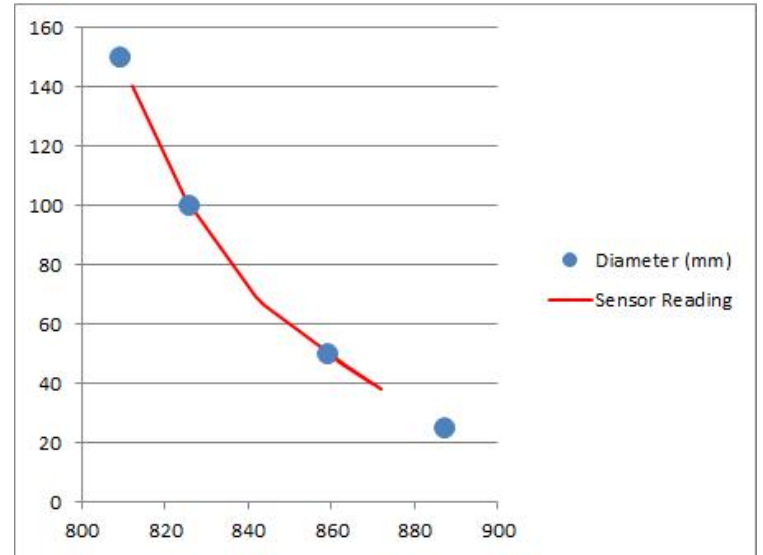
Figure 17. Spline curve adjustment to fit values from the finger bending sensors to spherical shapes.